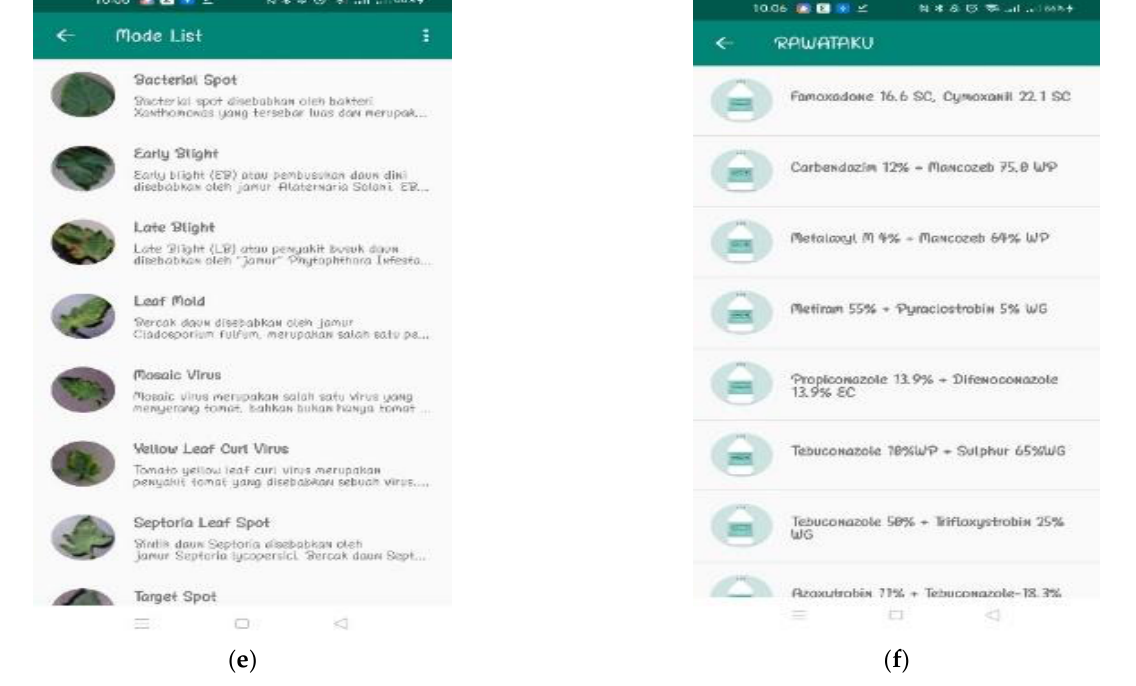
Figure 5. Mobile apps user interface. ( a ) Welcome page; ( b ) login page; ( c ) registry page; ( d ) home page; ( e ) disease recognition page; and ( f ) disease treatment page.